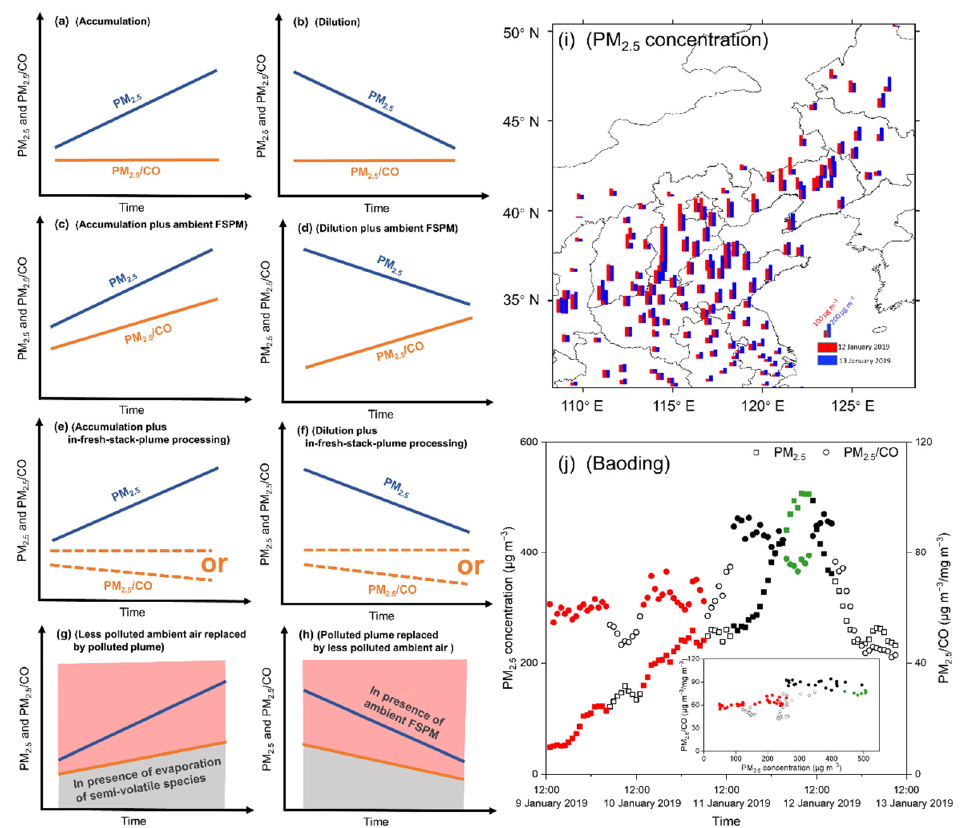
Figure 2. Theoretical analysis of PM 2.5 and PM 2.5 /CO change under two conditions, that is, accumu- lation and dilution, in the presence or absence of ambient FSPM and in-fresh-stack-plume non-pre- cipitation-cloud processing of aerosols ( a – h ); red shadow and grey shadow represent the presence